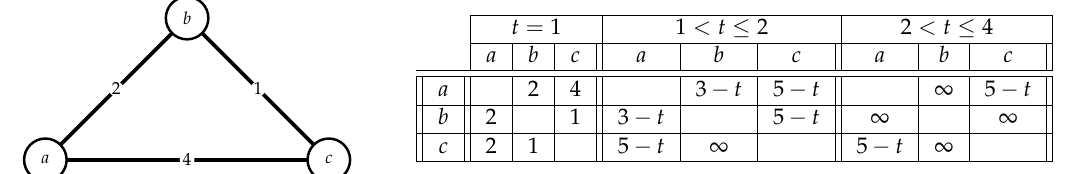
Figure 1. An example of a temporal undirected graph with the three temporal edges ( a , b ,2 ) , ( a , c ,4 ) , and ( b , c ,1 ) ( left ) and of the corresponding t -distances ( right